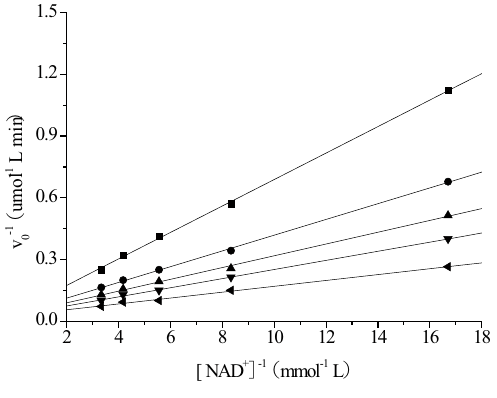
Figure 3. Double reciprocal plot of the initial rate vs. the concentration of NAD + at different C 100 reverse micelle. ω 10 ( ■ ), 20 ( ● ), 25 ( ▲ ), 30 ( ▼ ), 40 ( ◄ ) mmol L -1 .